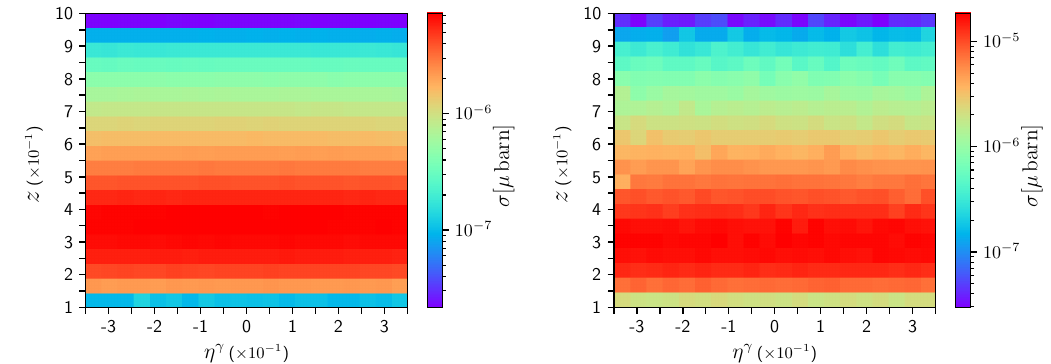
Figure 9: Partonic momentum fraction z as a function of the rapidity of the photon. The color scale shows the cross-section at LO QCD (left) and NLO QCD + LO QED (right) accuracy. We simulated the events using RHIC kinematics with